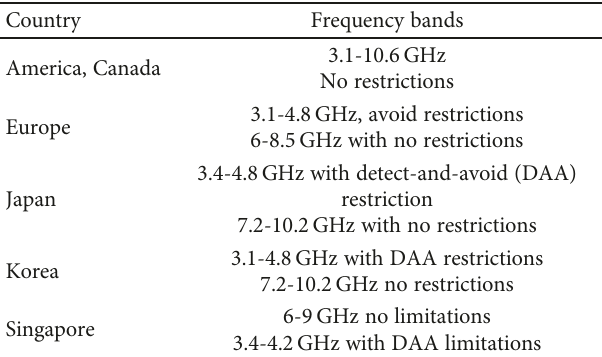
Table 1: UWB standards